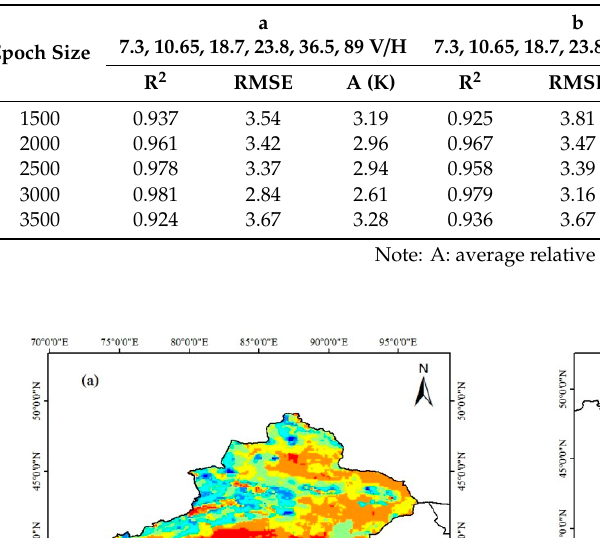
Table 3. Errors resulting from different channel combinations in Xinjiang, Inner Mongolia and Northeast China.